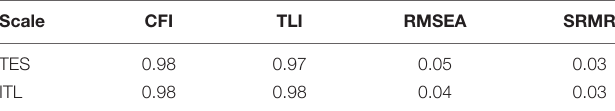
TABLE 1 | CFA results for confirming the internal factor structures for the TES and